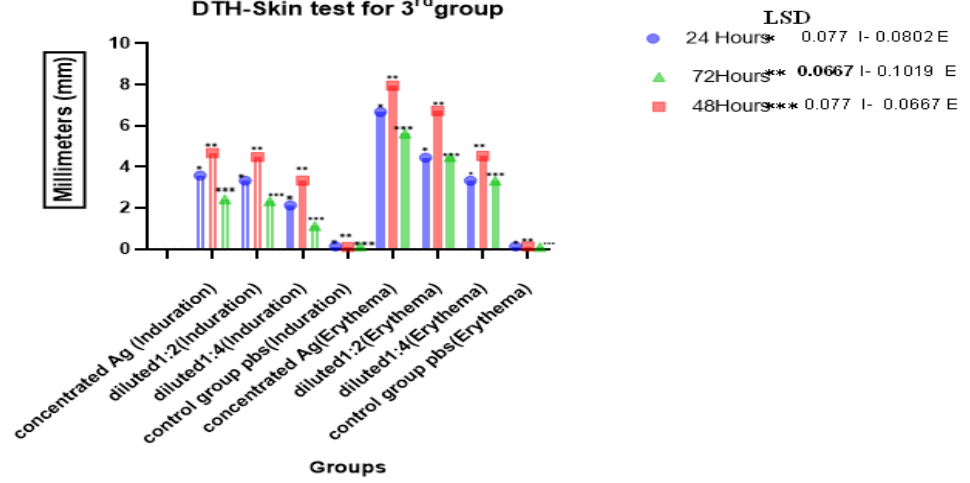
Figure 5. DTH test induration and erythema of rabbits immunized by DNA